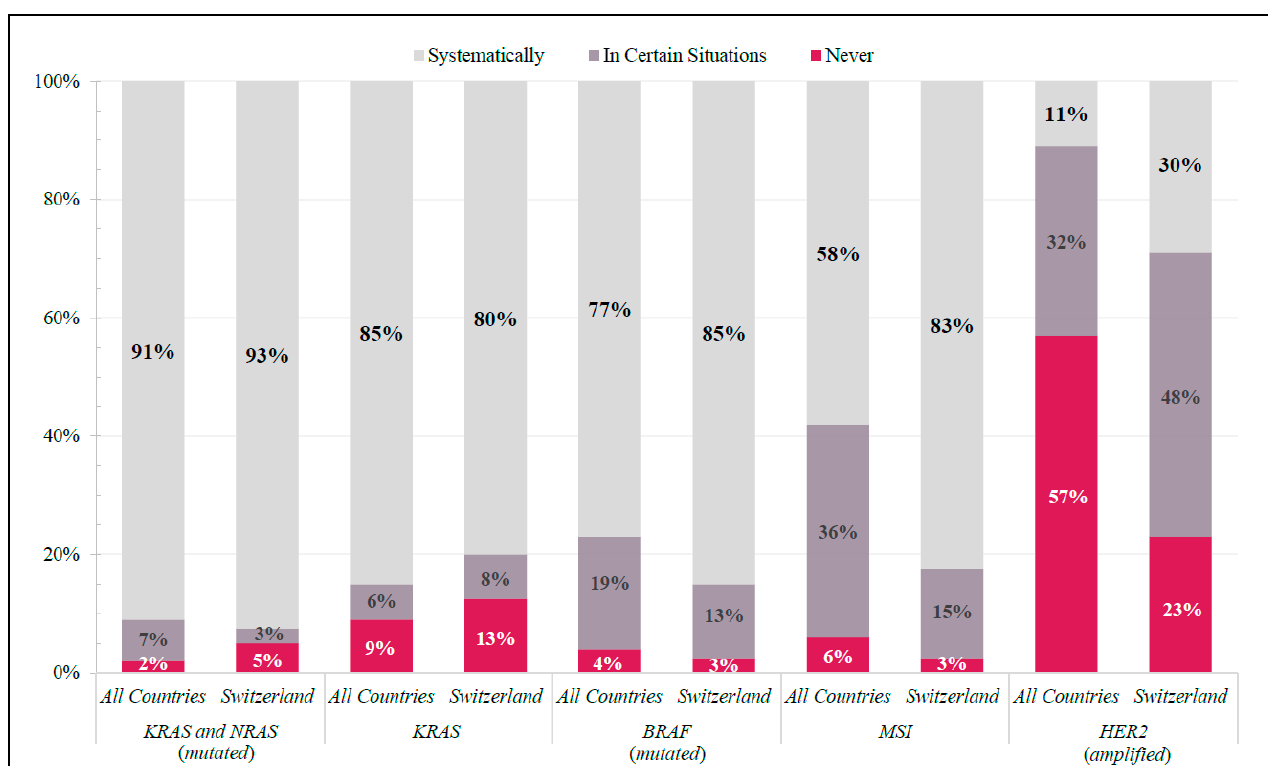
Figure 1. Molecular Diagnostics . Frequency of responses in Switzerland and All Countries (shown as percentage of total respondents in each group) to specific molecular diagnostic tests ordered in real-world clinical practice.